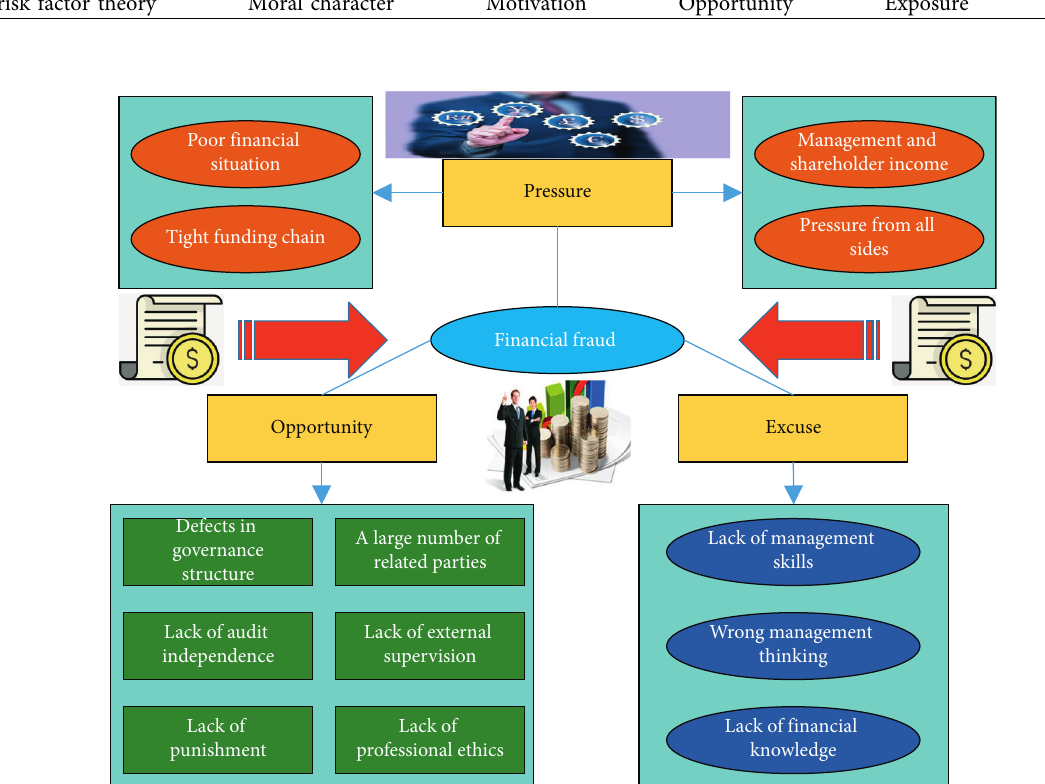
Figure 1: The mechanism of financial fraud formation.